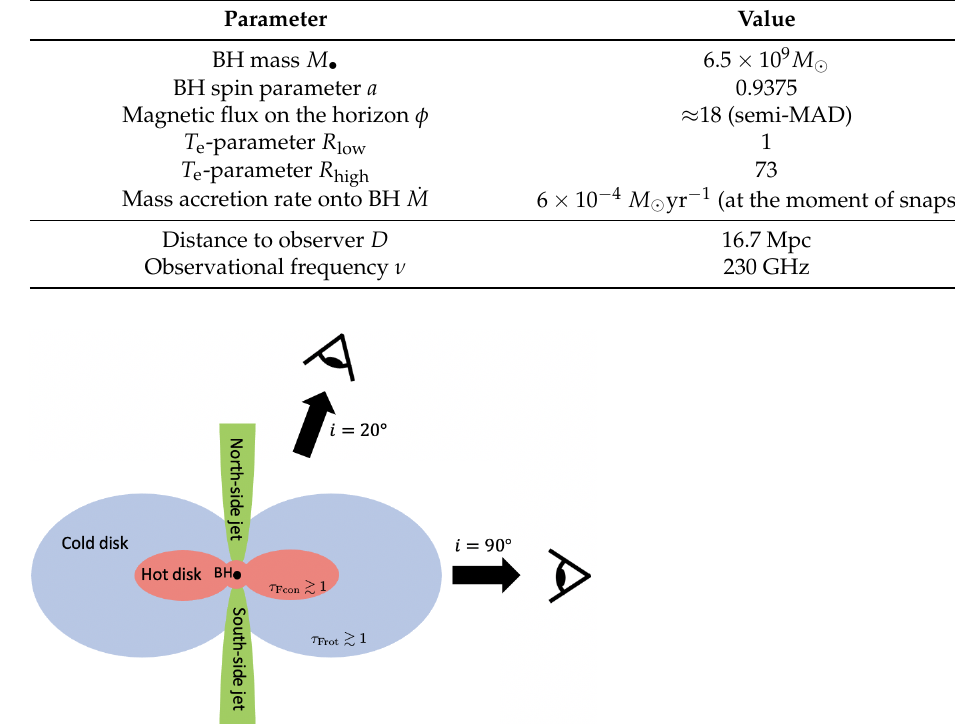
(cid:113) ˙ Mr g c 2 is a